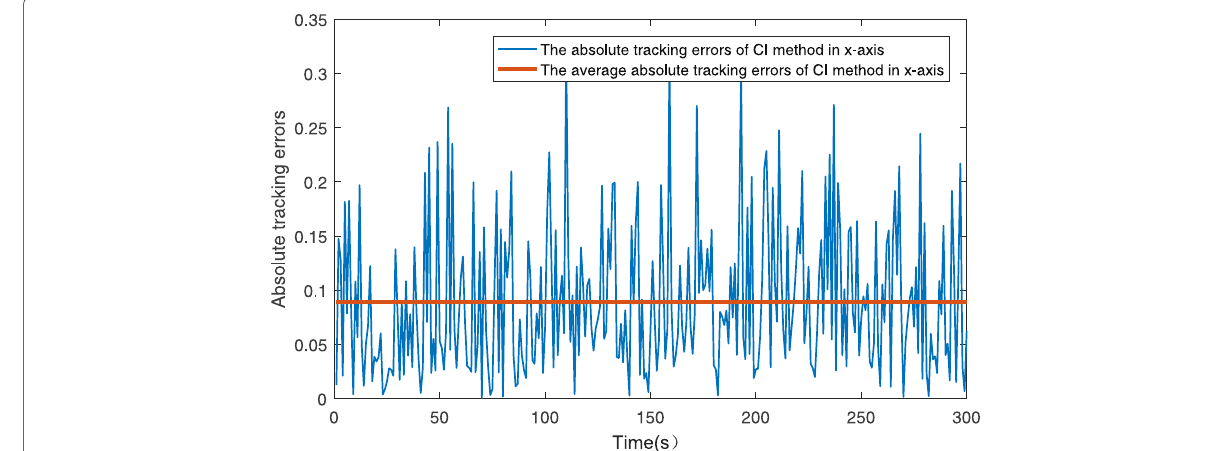
Fig. 10 The absolute tracking errors of CI method in x -axis with a i = 12